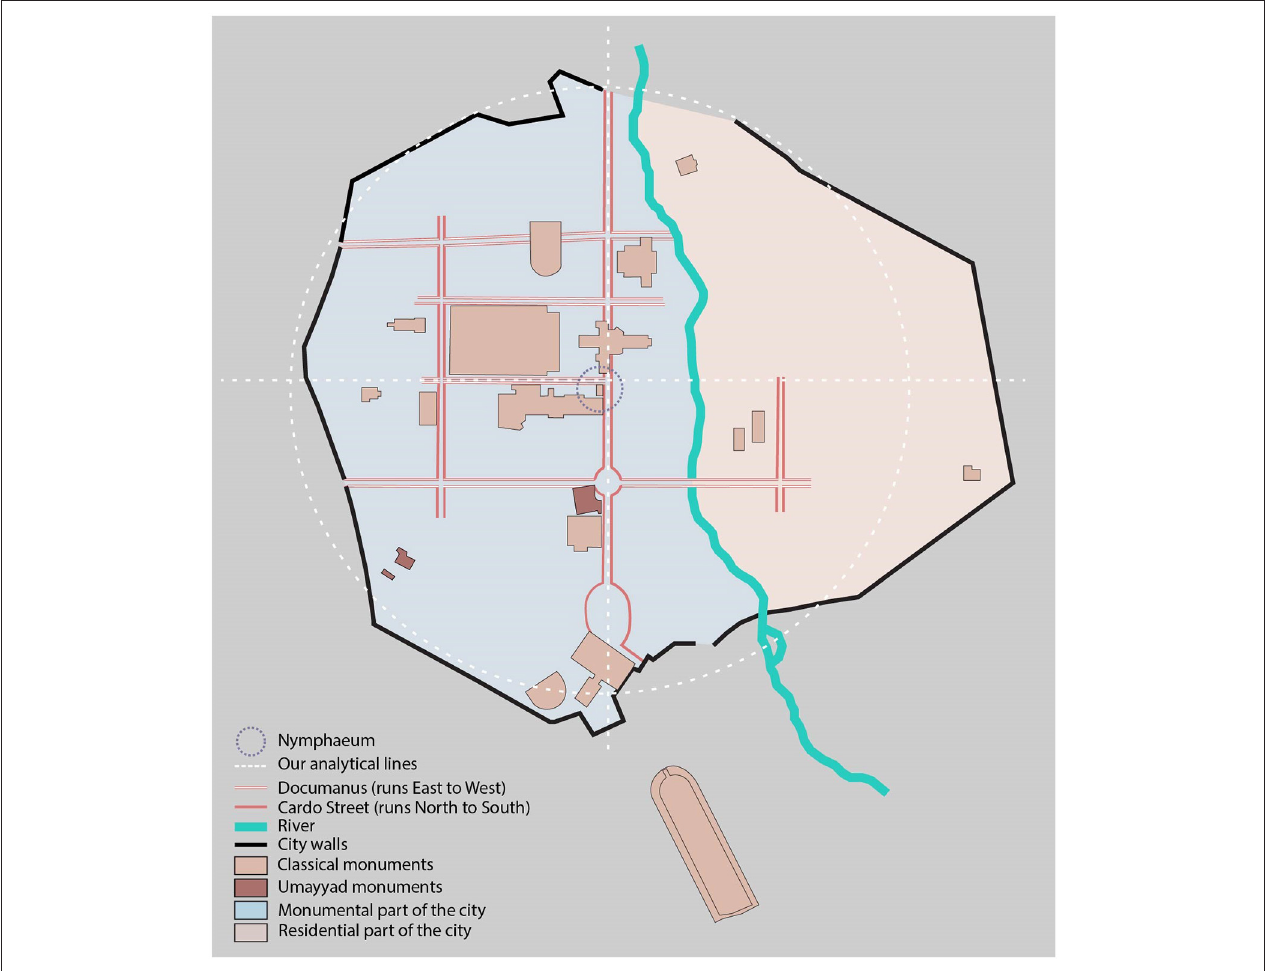
FIGURE 1 | Classical era Gerasa’s (contemporary Jerash) town plan showing the central location of the Nymphaeum and the strong connections to its Golden River (reproduced after Browning, 1982, p. 83 by Sophie Wang under the supervision of Dr. Luna Khirfan–analysis